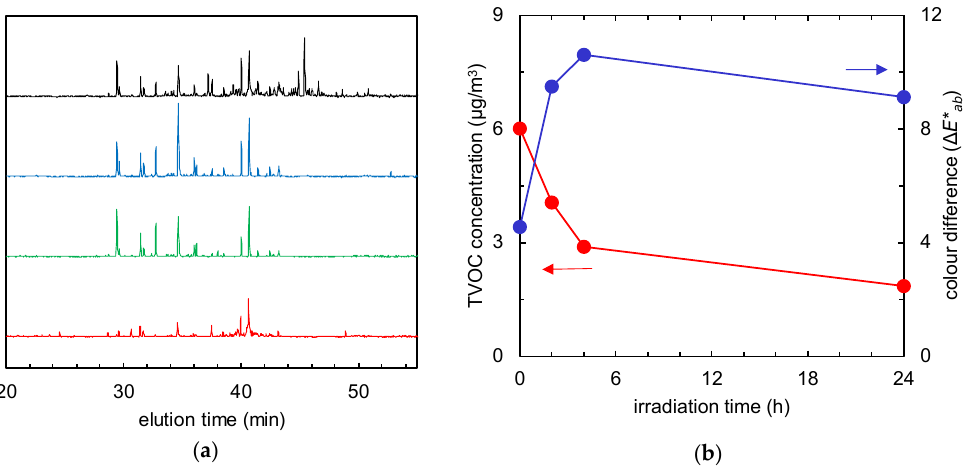
Figure 7. Time course of total volatile organic compound (TVOC) concentration (red) and the colour difference (the E * ab value compared to the colour of the fabric before tobacco smoke adsorption, shown by the blue line) of the fabrics after tobacco smoke adsorption vs. visible light irradiation time. ( a ) Non ‐ woven fabric with Fe/TiO 2 ; ( b ) non ‐ woven fabric without Fe/TiO 2 . Another type of visible ‐ light ‐ activated photocatalyst, Cu/WO 3 , showed different results, and Figures 8 and 9 report the behaviour of the non ‐ woven fabric samples embedded with this catalyst. Although the normalised GC ‐ MS chromatograms of the solid ‐ phase ‐ extracted odour components (Figure 8a) and the time course graphs of TVOC concentration (Figure 8b, red line) indicate that the odour components were decomposed, the colour did not revert to white after 24 h of irradiation (Figure 8b, blue line); instead, the colour of the fabric changed from yellow to dark yellow (Figure 9).